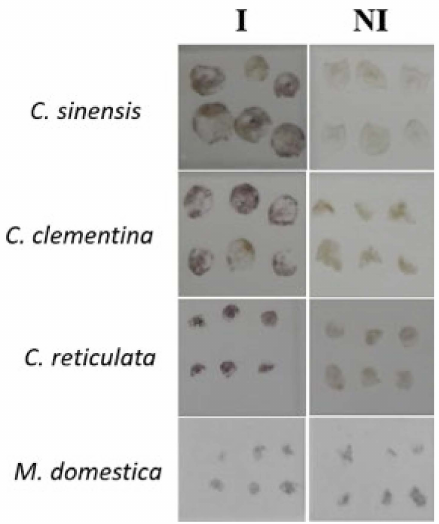
Figure 1. Direct tissue blot immunoassay (DTBIA) for CCGaV detection in citrus and apple trees. CCGaV-infected ( I ) and noninfected ( NI ) trees previously assayed by DAS-ELISA and RT-PCR (see Tables 1 and 2) were tested. A representative subset of the results is shown, including I and NI tender shoot sections of Citrus sinensis and C. clementina , and leaf petiole sections of C. reticulata and Malus domestica . In each grid, six prints representative of different branches of a tree canopy are blotted. Purple coloration is visible on sections of CCGaV-infected C. sinensis , C. clementina and C. reticulata (MAD5, NAP1, and POR1 trees, respectively). No purple coloration is visible on sections of CCGaV-infected M. domestica (CE-c24 tree), indicating that the method is not efficient in apple.